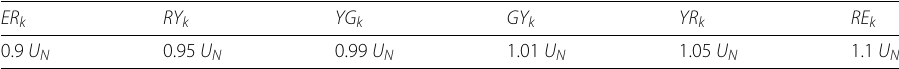
Table 2 Thresholds of the voltage KPI class from criteria A 2 ER